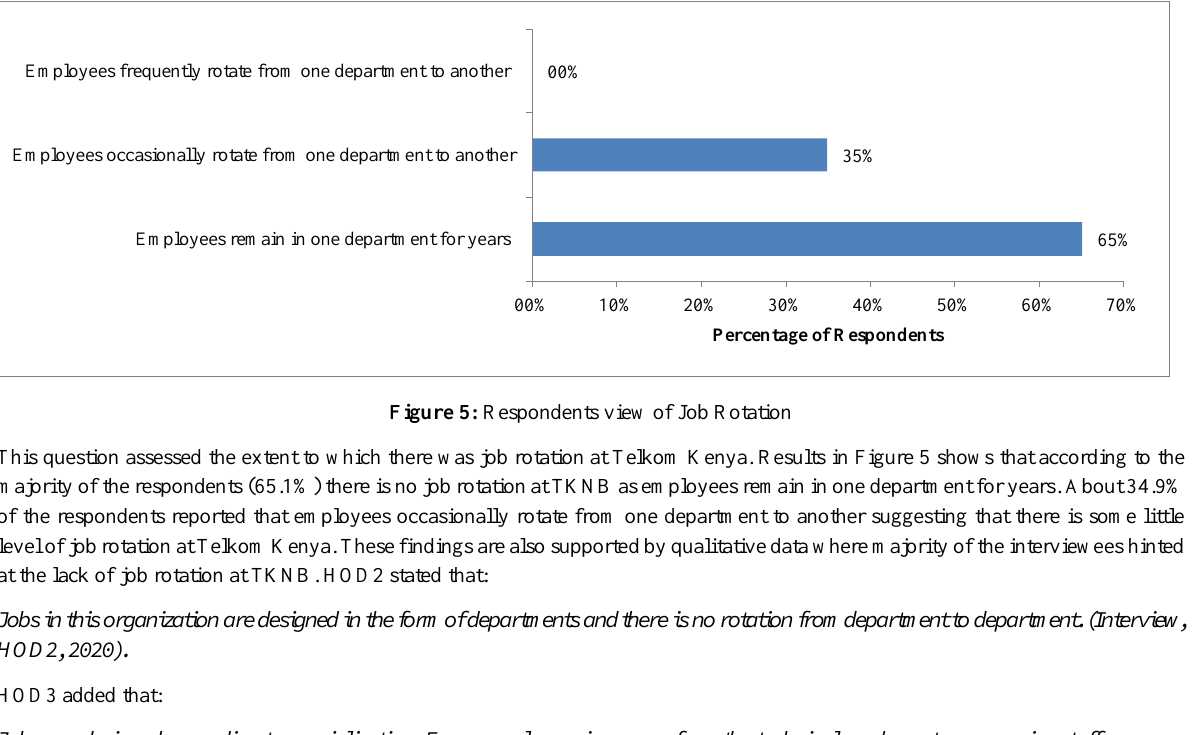
Table 5: Respondents views on Job-Skill Matching at Telkom Kenya